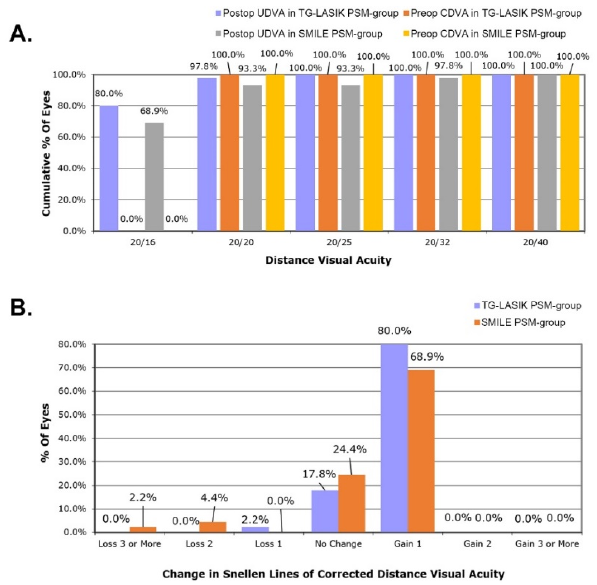
Figure 3. ( A ) Distance visual acuity following TG ‐ LASIK and SMILE. ( B ) Changes in postoperative Snellen lines of CDVA compared with preoperative CDVA in TG ‐ LASIK and SMILE propensity ‐ score ‐ matched groups. (TG ‐ LASIK, topography ‐ guided laser ‐ assisted in situ keratomileusis; SMILE, small incision lenticule extraction; UDVA, uncorrected distance visual acuity; CDVA, corrected distance visual acuity).